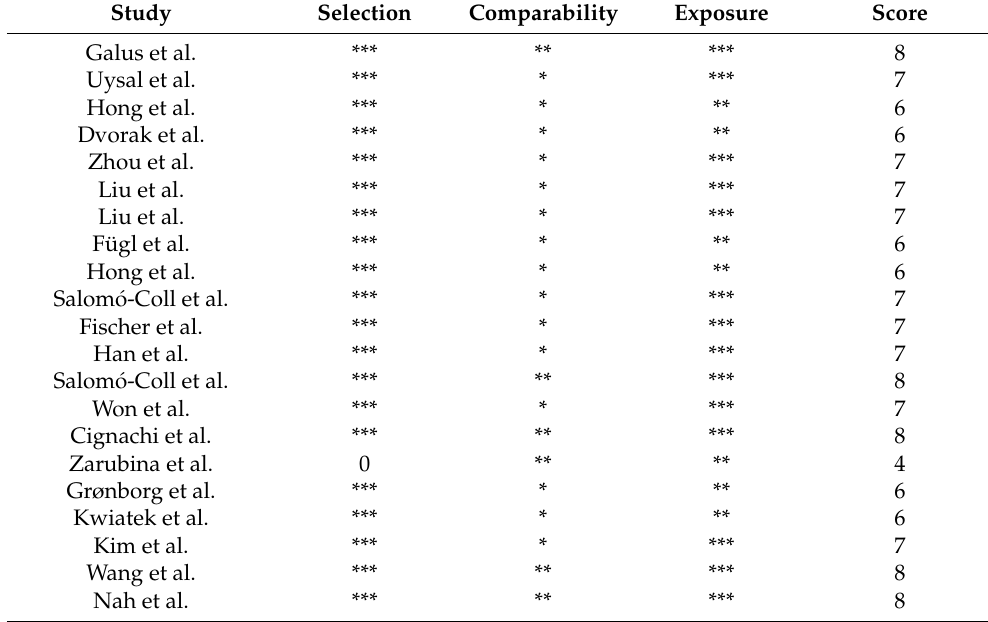
Table 1. The Newcastle–Ottawa